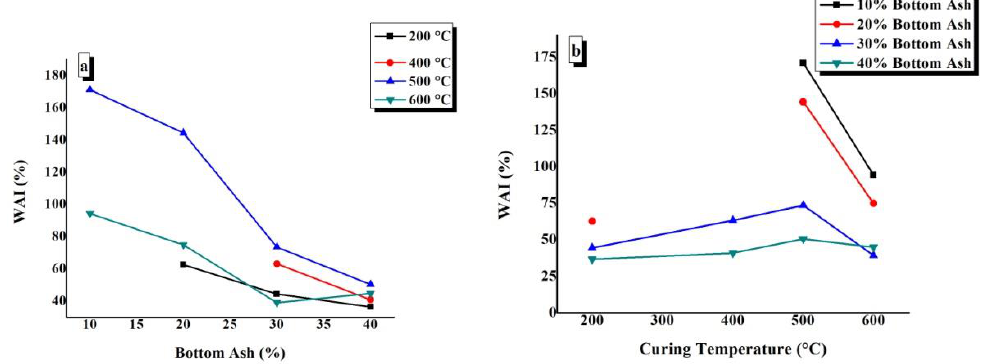
Figure 9. Effect of ( a ) bottom ash content and ( b ) curing temperature on the water absorption index (WAI) of TGPFs.